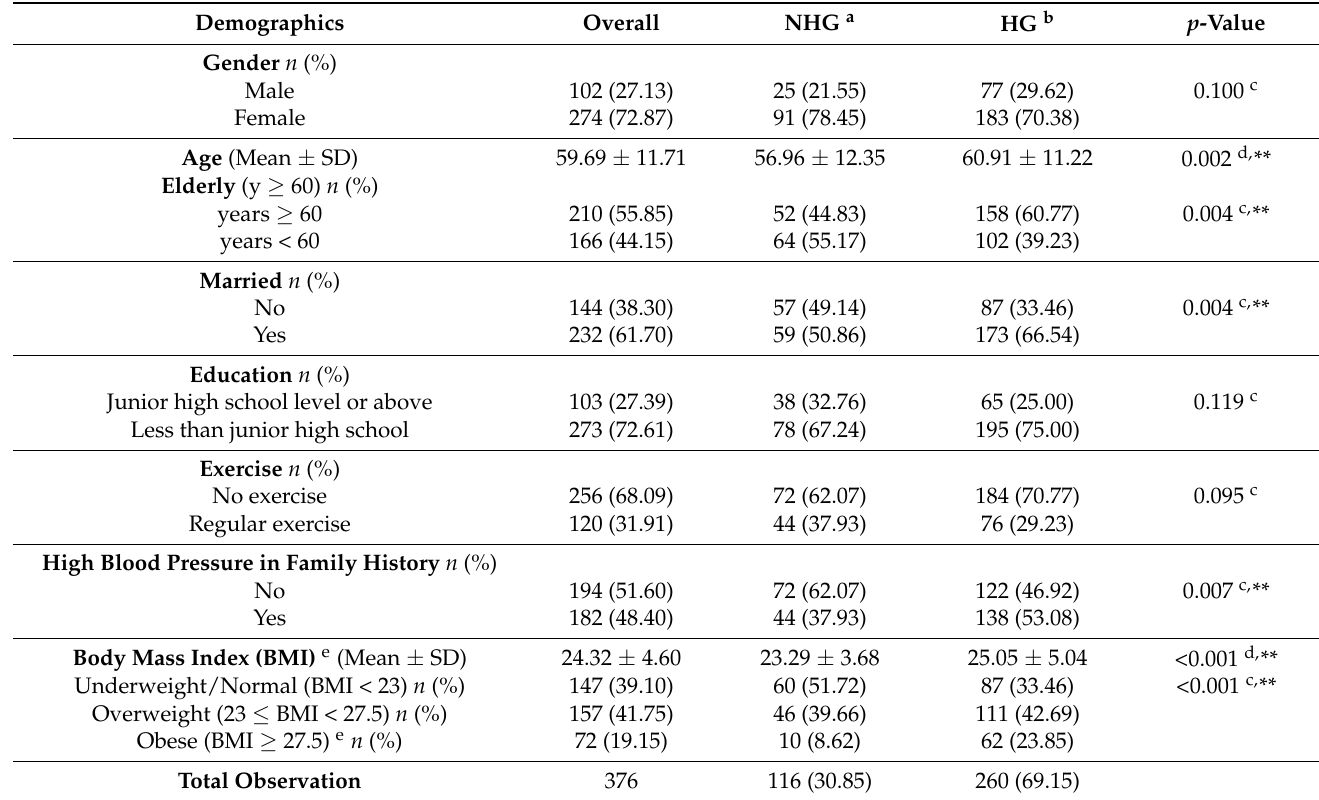
Table 1. Sociodemographic characteristics of subjects associated with hypertension.